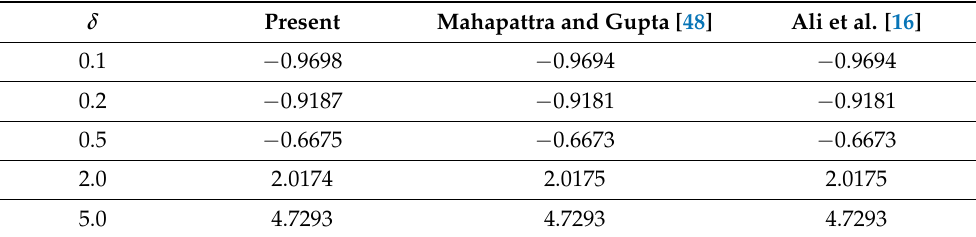
Table 2. The Local Skin Friction coefficient for diverse values of δ when β = 0, p = 1.0, λ = 0.0, N = 0.0, γ = 1.0, p r = 0.72, ξ = 0.